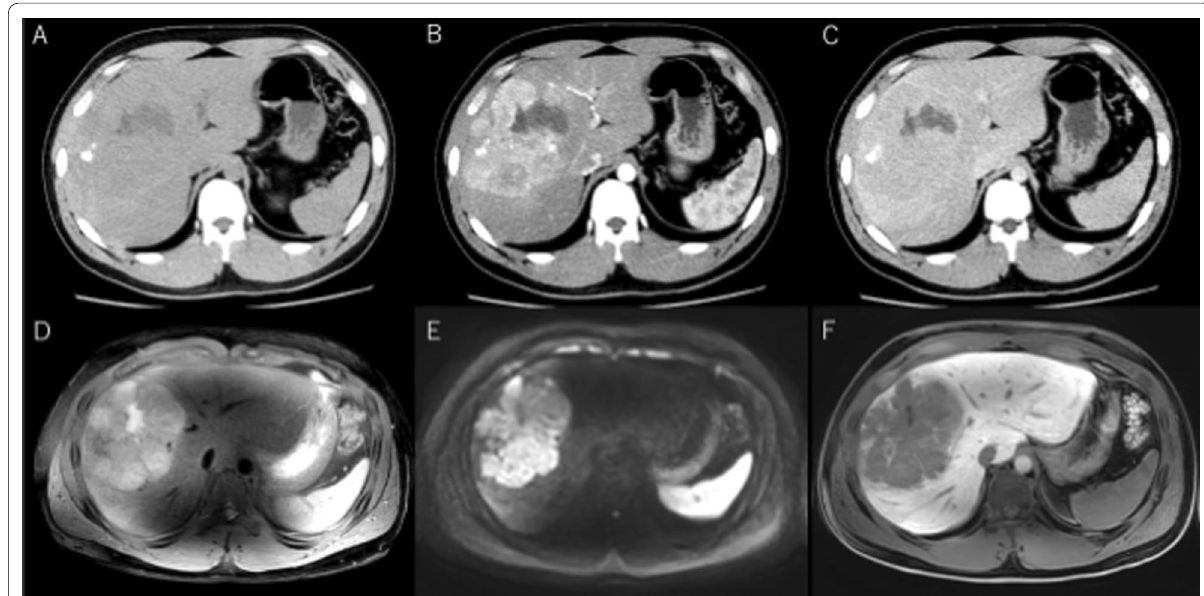
Fig. 1 Dynamic computed tomography (CT) and gadoxetic acid-enhanced magnetic resonance imaging. A lobulated mass is visualized located in the anterior sector of the liver. The tumor was seen as a low-attenuating lesion in unenhanced images ( A ) and as a heterogeneous hyperattenuation in the arterial phase of dynamic CT ( B ). Hyperattenuation in the arterial phase suggests hypervascularity. The tumor demonstrated washout in the delayed phase of dynamic CT ( C ). The central scar showed a gradually enhancing pattern with calcification. The scar was seen as a hypointensity on T2WIs ( D ) and as a marked hyperintensity on DWIs ( E ). The tumor was visualized as a low signal intensity in the hepatobiliary phase, without gadoxetic acid uptake. Also, the tumor was observed as having a lobulated appearance in the hepatobiliary phase ( F